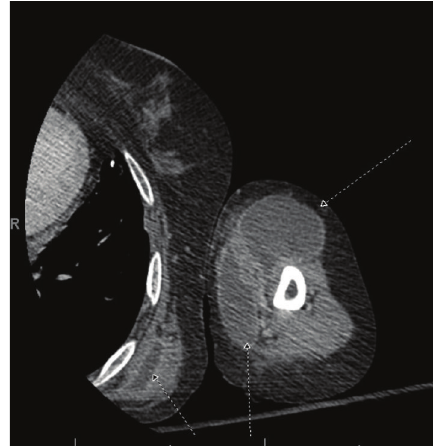
Figure 2: Multiple abscesses in the left upper extremity and chest wall.